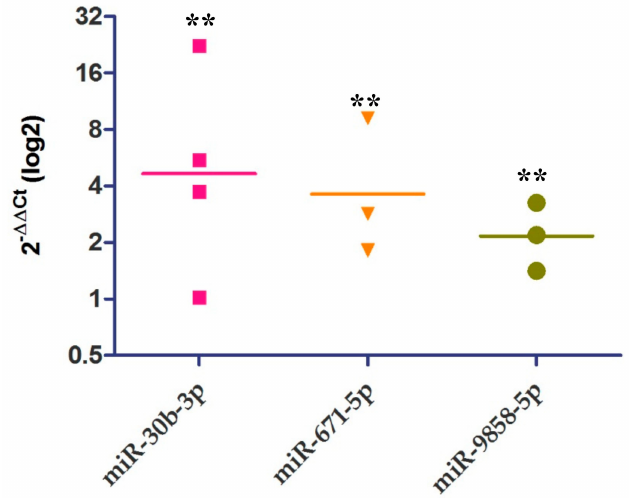
Figure 4. MiRNAs are increased after BB12 stimulation. The relative expression of miRNAs miR-30b-3p, miR-671-5p, and miR-9858-5p was determined using RT-qPCR in unstimulated and BB12-stimulated (BB12) moDCs via the 2 − ∆∆ C t method. The graph shows the geometric mean values of at least three independent experiments (each point represents one pig); comparisons were made between unstimulated versus BB12-stimulated moDCs for each miRNA ( p < 0.05**), and y-axis represents foldchange relative expression. Mann–Whitney test for non-parametric data was used. The expression of ssc-U6 was used to normalize the